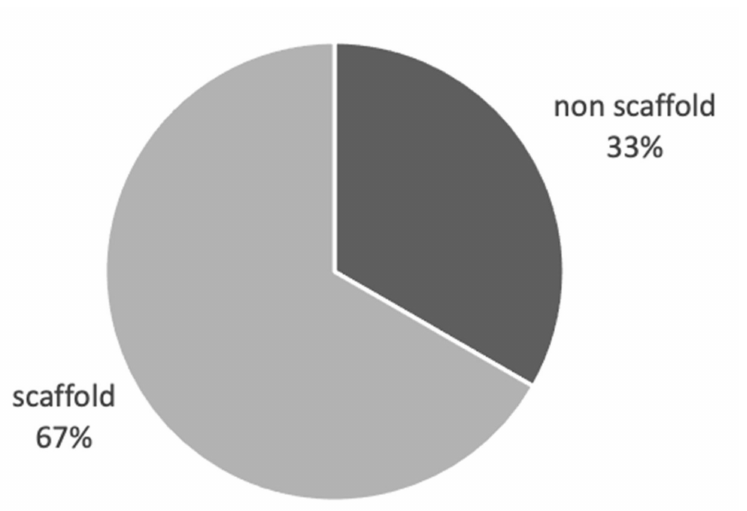
Figure 5. EMT studies: Scaffold vs. non scaffold. Proportional representation of scaffold and non-scaffold based studies exploring EMT, highlighting the importance of ECM in the